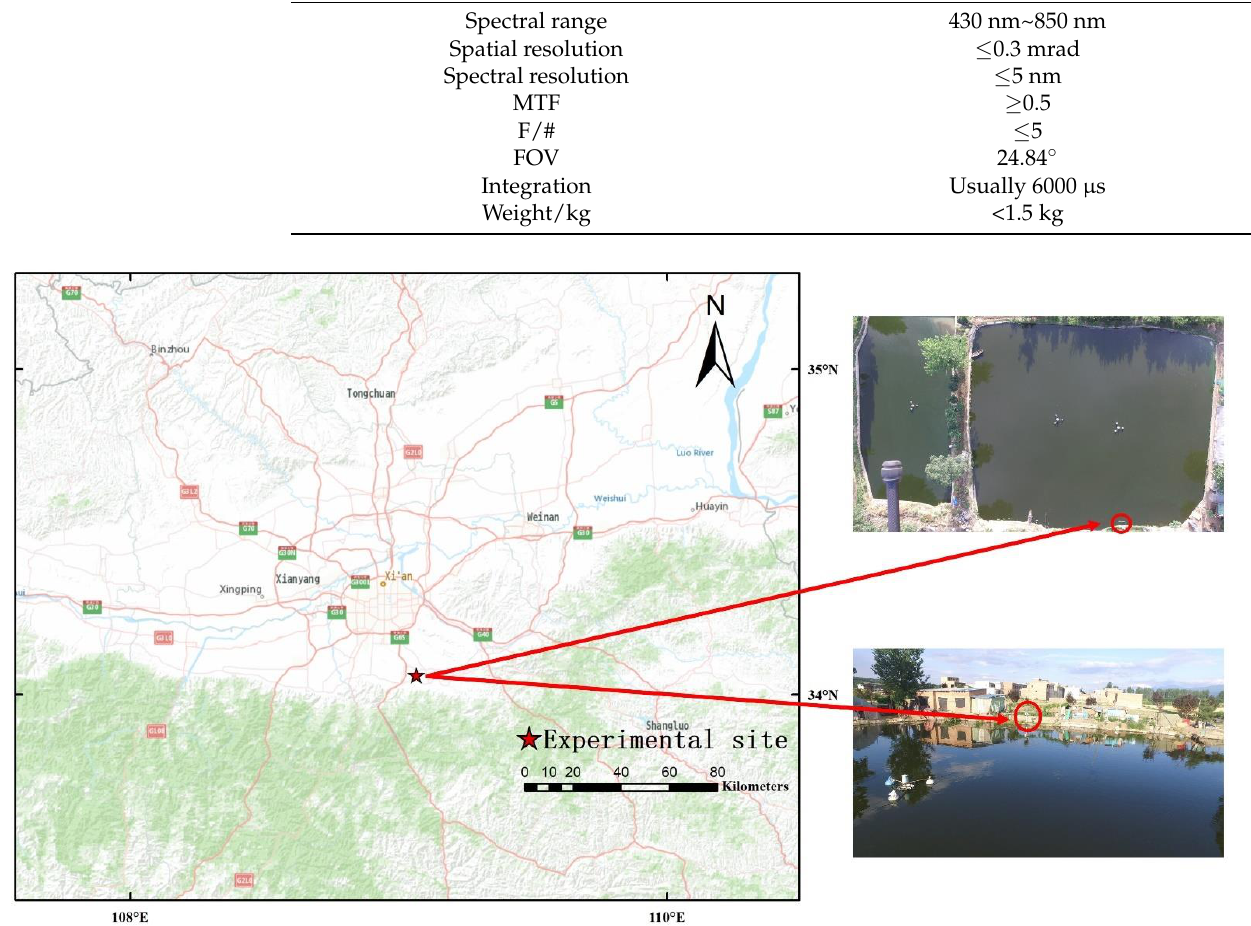
Figure 3. Location of the experimental site and top and side views from the perspective of UAV.